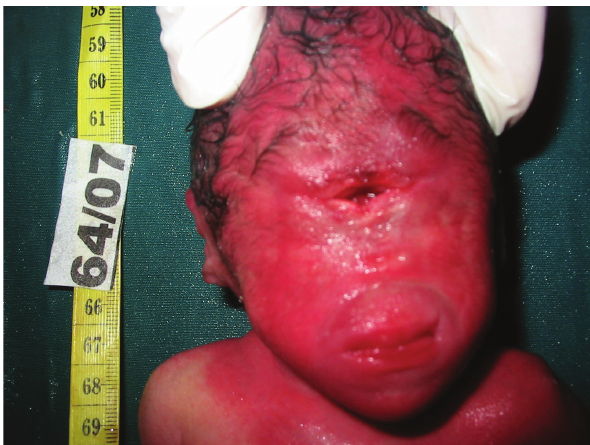
Figure 1: Fetus with cyclopia, agenesia nasalis and cleft cheek.